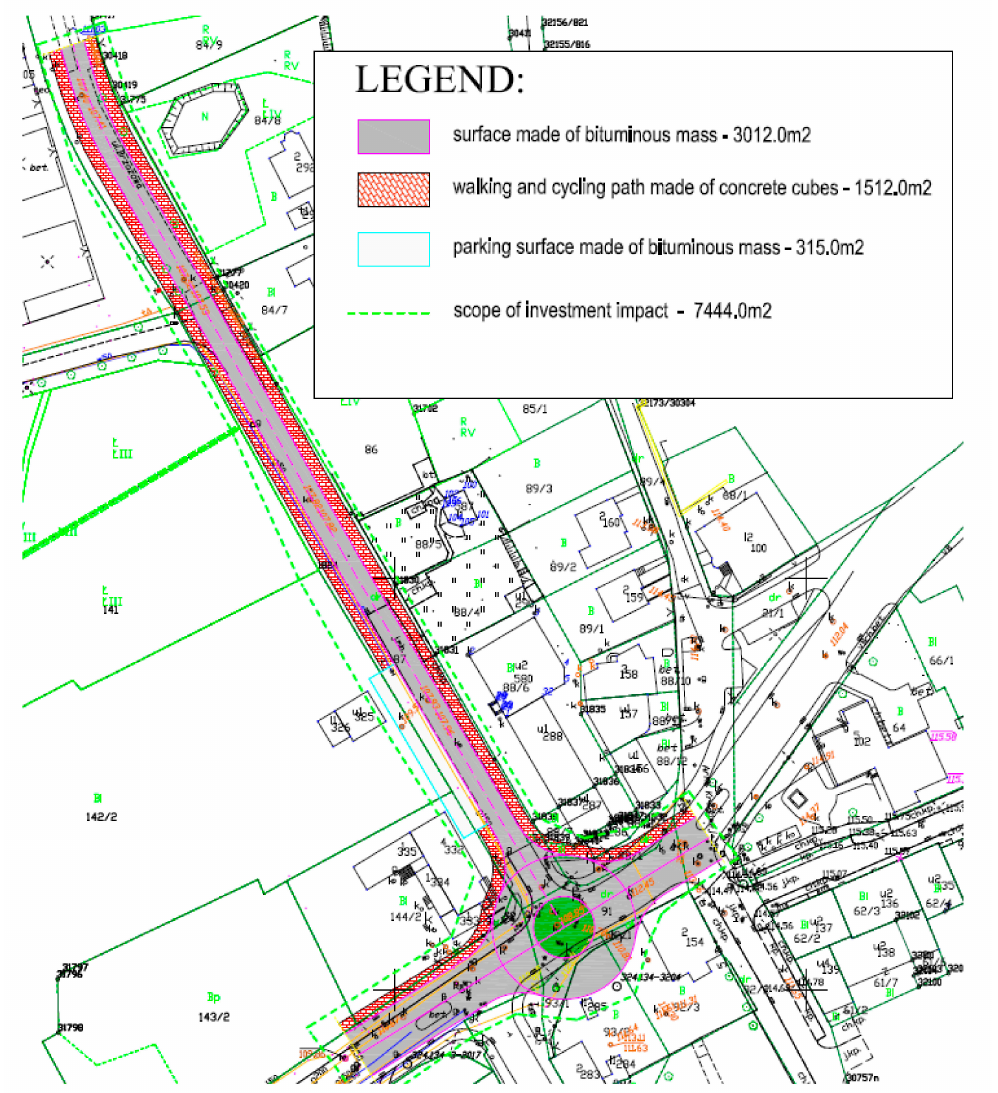
Figure 7. Site plan-proposed solution for the road layout at the intersection—option